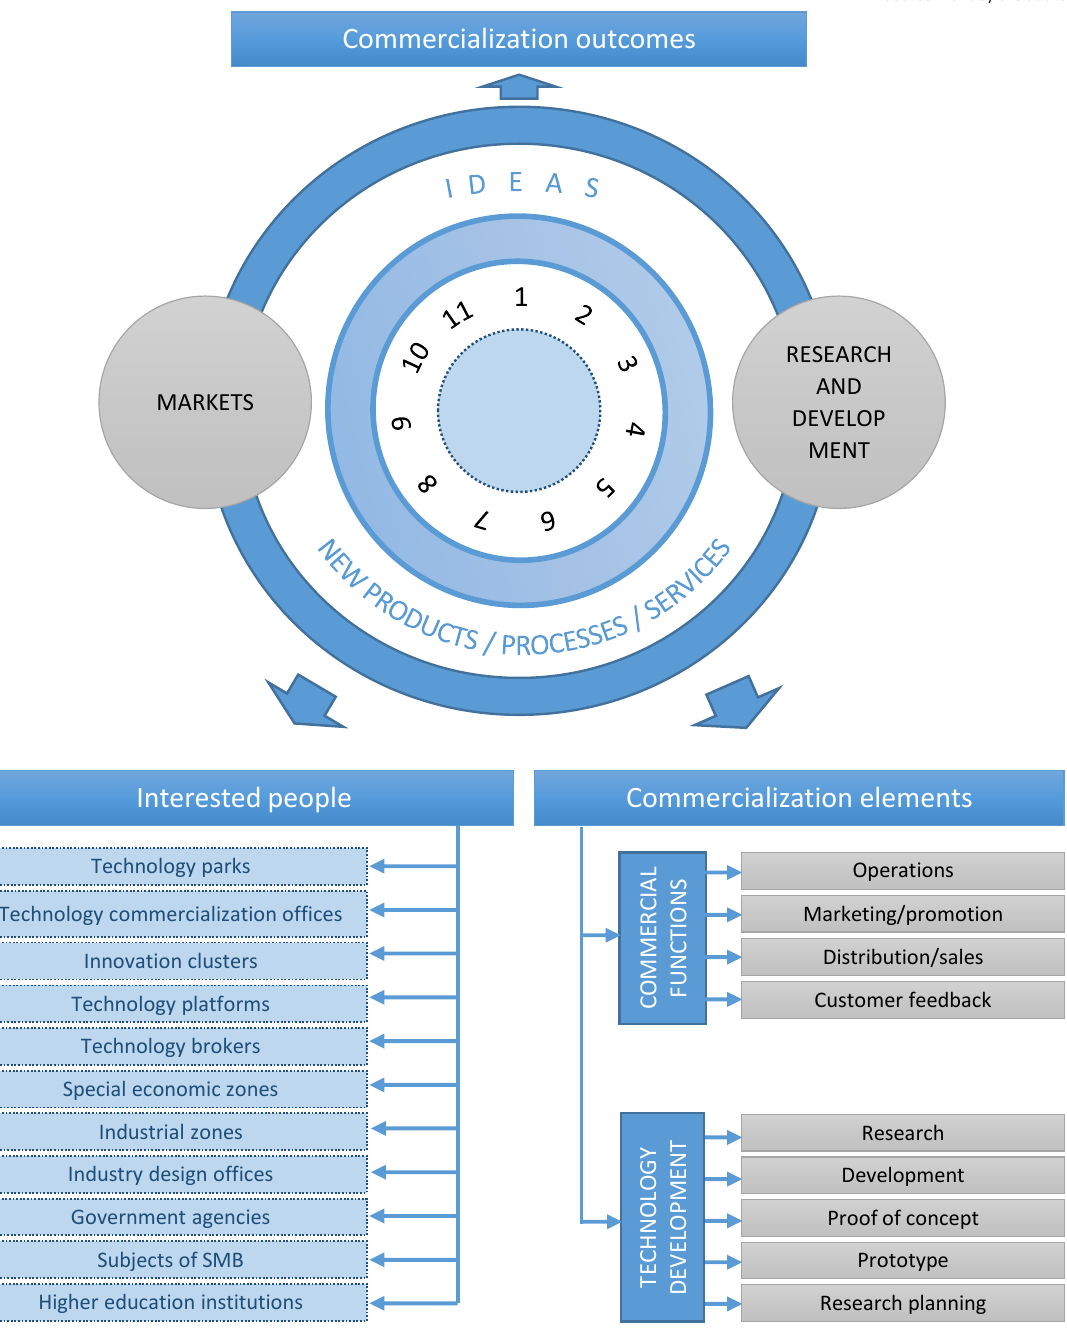
Figure 2. Diversification model of R&D